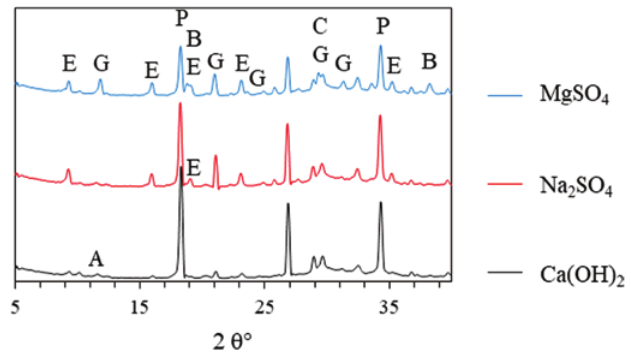
Figure 10 QF diffractograms after 20 weeks of exposure to Ca(OH) , Na SO and MgSO . 2 2 4 4 Monocarboluminate (A), brucite (B), calcite (C), ettringite (E), gypsum (G) and portlandite